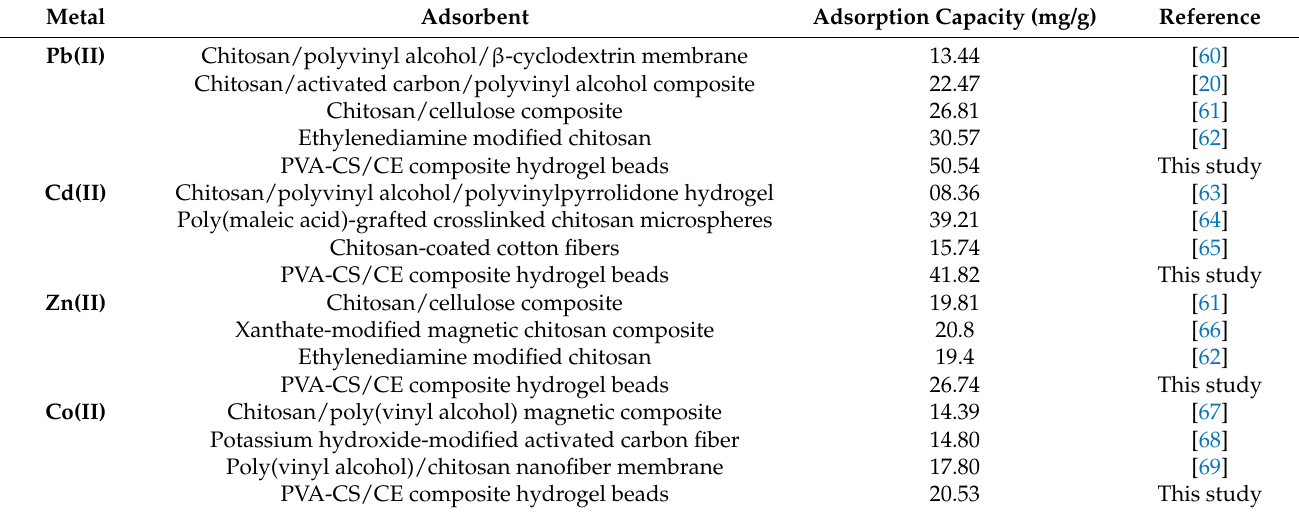
Figure 10. Adsorbent–adsorbate interaction mechanisms for the heavy metal ions decontamination of water by PVA-CS/CE composite hydrogel. Table 3. Comparison of adsorption capacities of Pb(II), Cd(II), Zn(II), and Co(II) for different Ad- sorbents.